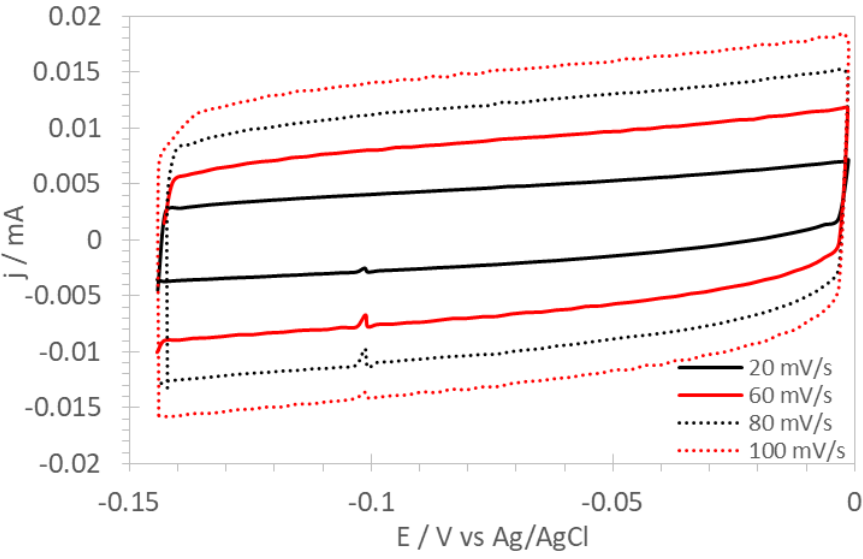
Figure 2. Cyclic voltammograms of PSU-TMA + PANI + GAH-Oct fibers. The double-layer capacitance C is determined from the non-Faradaic current density at various scan rates, according to Equation (4):